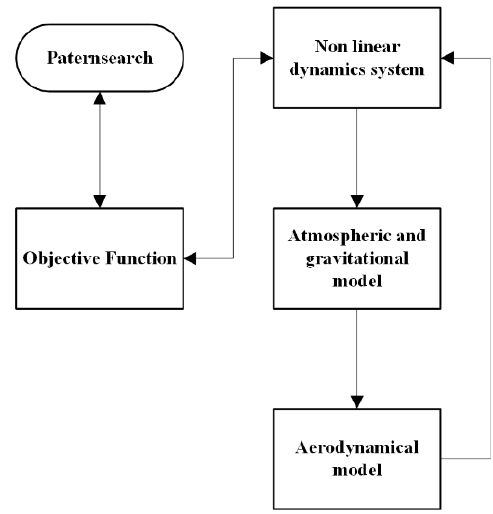
Figure 3. Trajectory optimization algorithm diagram.